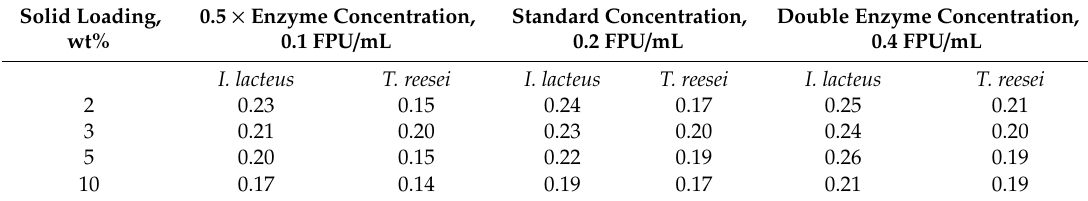
Table 2. Fermentable sugar yields (g reducing sugar per g dry biomass) at systems with variable solid loadings and variable final enzyme